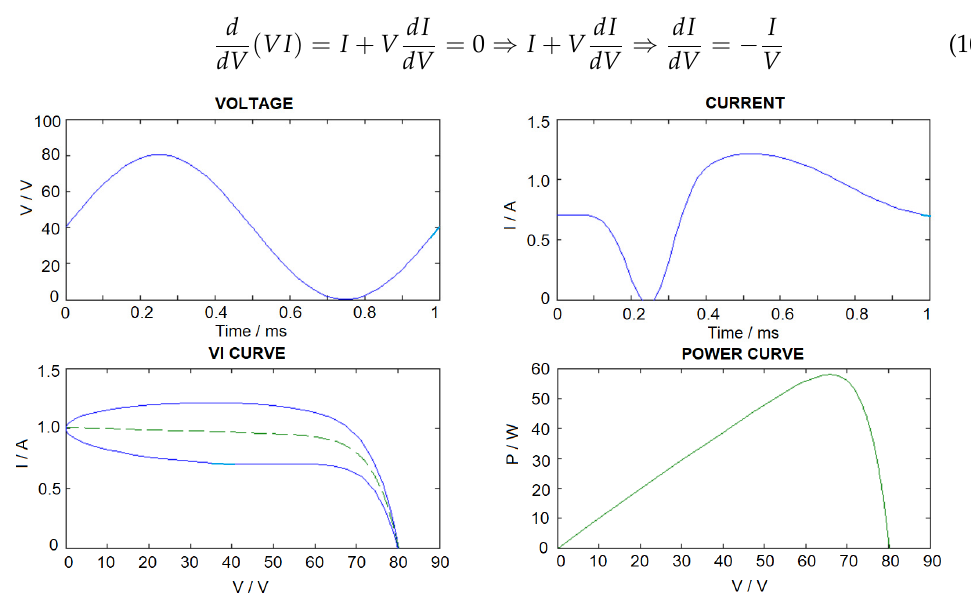
Figure 3. Sample VI and power curve (I ph = 1, I o = 1 × 10 − 7 , V T = 5, R sh = 1000, C sh = 1 × 10 − 6 , R s = 1). Blue (dynamic characteristics) Green (static characteristics)